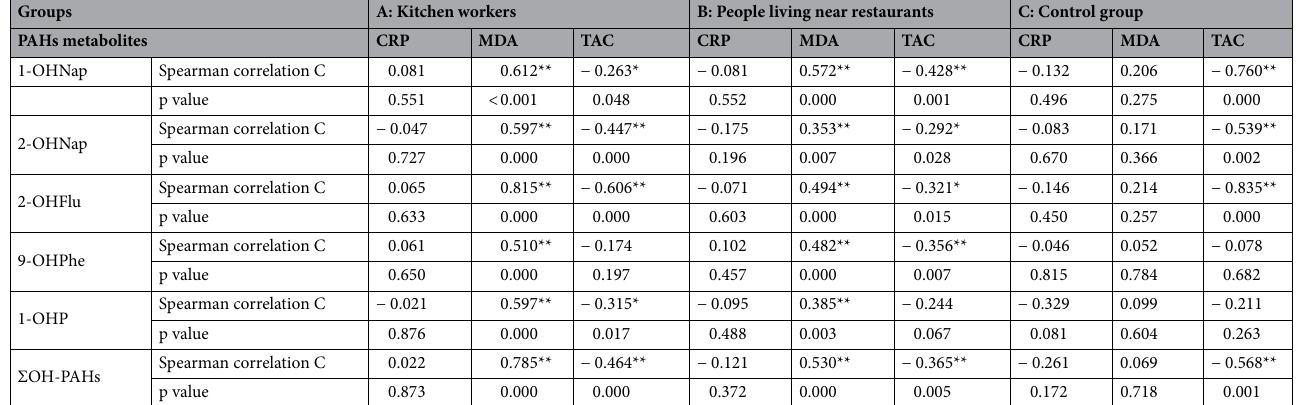
Table 3. Correlations between PAH s metabolites concentration (ng/g cr) and concentrations of MDA (mM/ mM cr), TAC (mM/mM cr) and CRP (mg/L) in the study